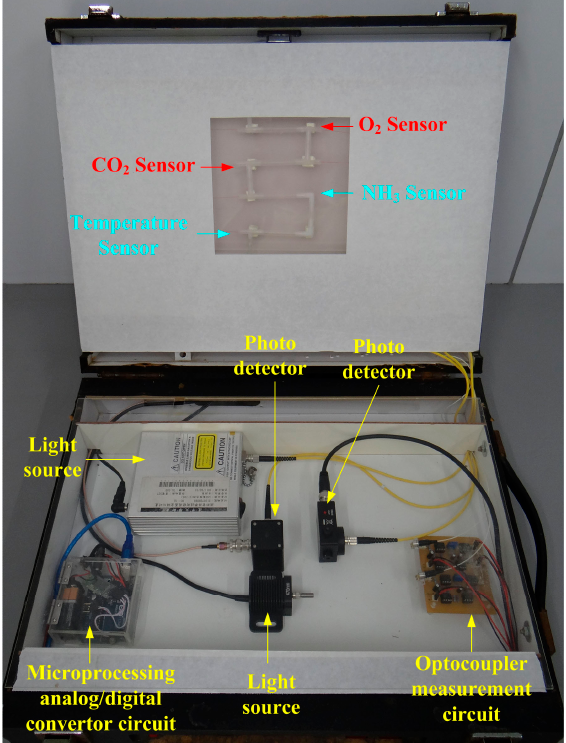
Figure 6. The photo of a prototype portable instrument.